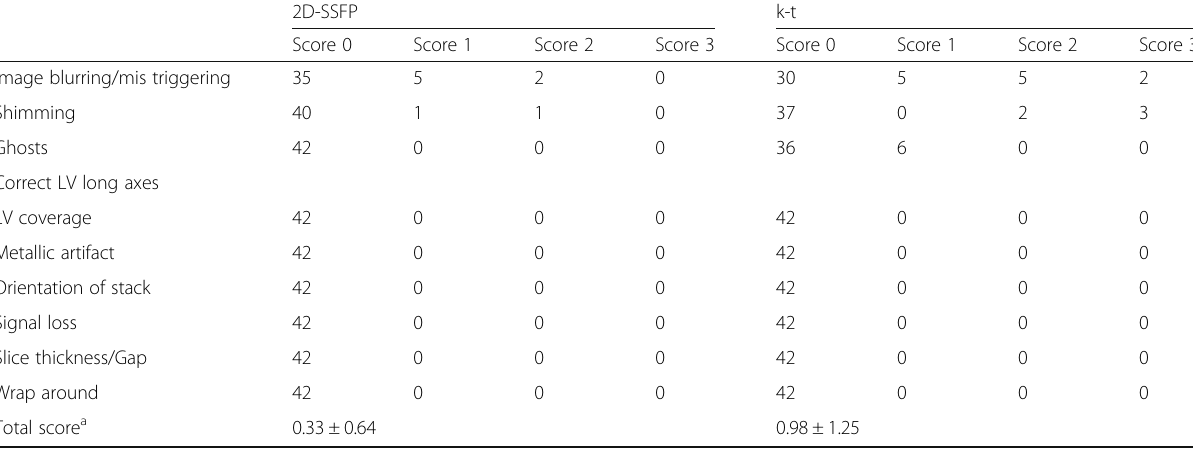
Table 2 Image quality of accelerated k-t SENSE and 2D-SSFP method